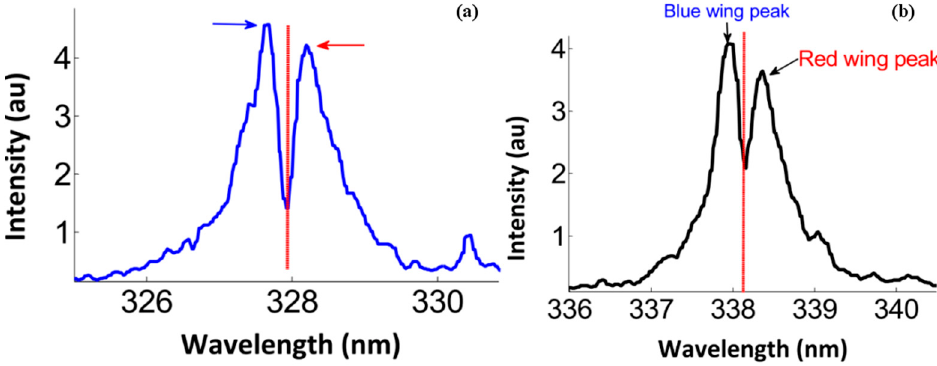
2 . ( a ) 327.9 nm and ( b ) 338.2